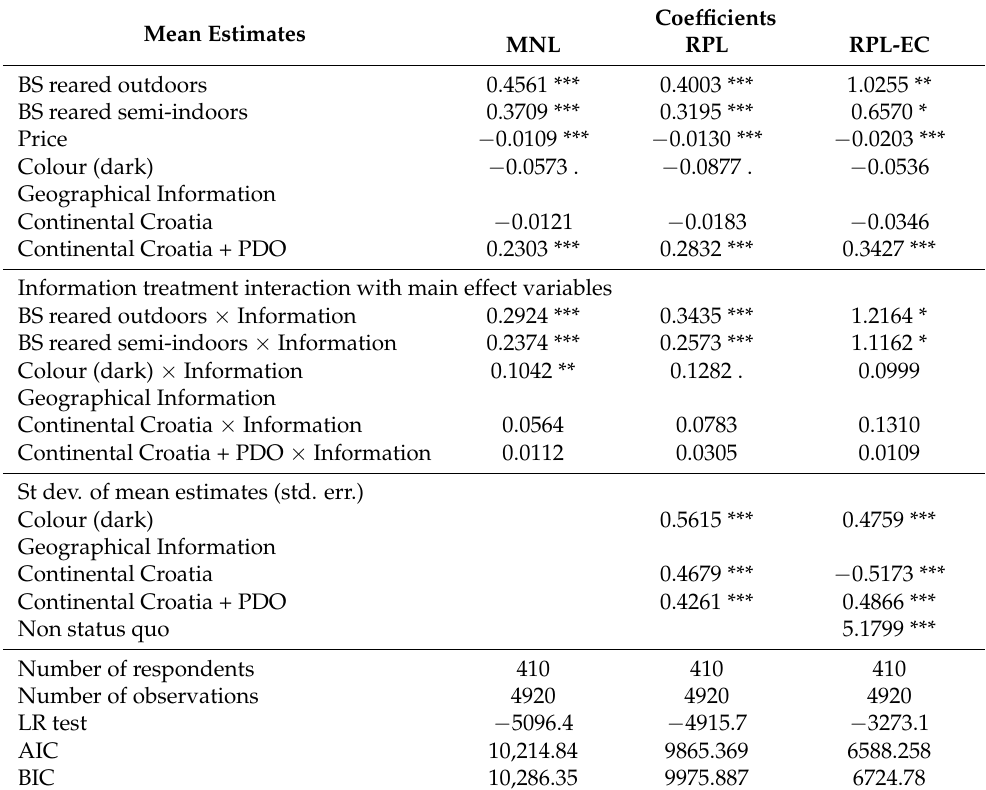
Table 3. Estimated parameters of the MNL, RPL, and RPL-EC models and interaction of information treatment with main effect